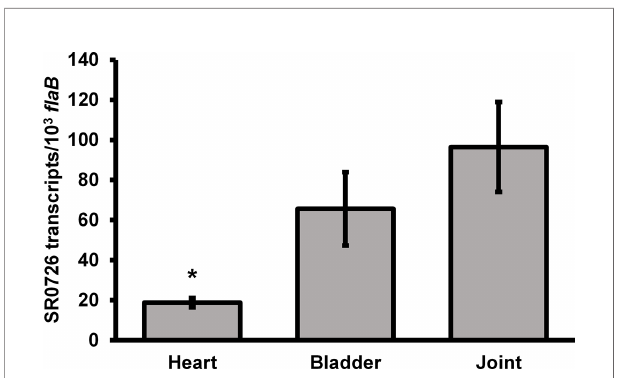
FIGURE 3 | SR0726 transcription is induced during mammalian infection. Three mice were inoculated subcutaneously with 10 5 wild type spirochetes. Infection was veri fi ed as before. Tissues were harvested for RNA extraction on day 28 post-infection. cDNA derived from indicated tissues was used in qRT PCR reactions similar to those used for assessment of SR0726 transcript levels in vitro . Error bars indicate SEM among biological replicates (n = 3). Asterisk indicates statistically different group ( P < 0.05) as determined by one ‐ way ANOVA followed by all pairwise multiple comparison (Holm ‐